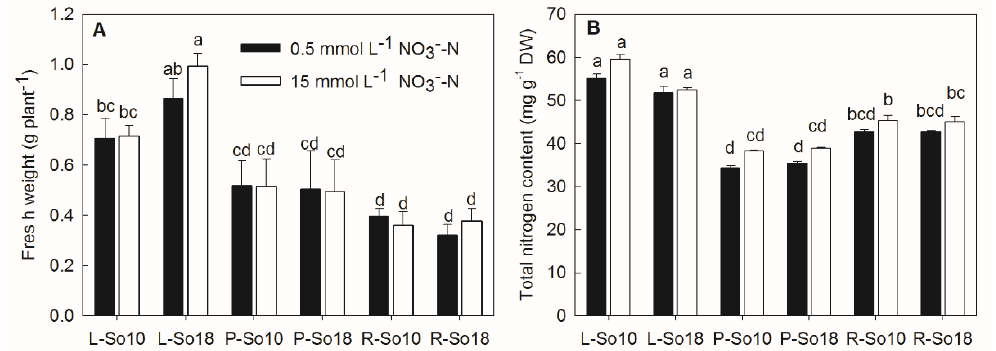
Figure 1. Fresh weights ( A ) and total nitrogen contents ( B ) of two spinach varieties (S10 and S18) after 12 h of nitrate treatment. L-So10, the leaf blades of S10; L-So18, the leaf blades of So18; P-So10, the petioles of So10; P-So18, the petioles of So18; R-So10, the roots of So10; and R-So18, the roots of So18. Different letters in columns indicate significant difference between the mean values at p < 0.05 by the LSD test ( n = 3). Values are provided as mean ± SD.